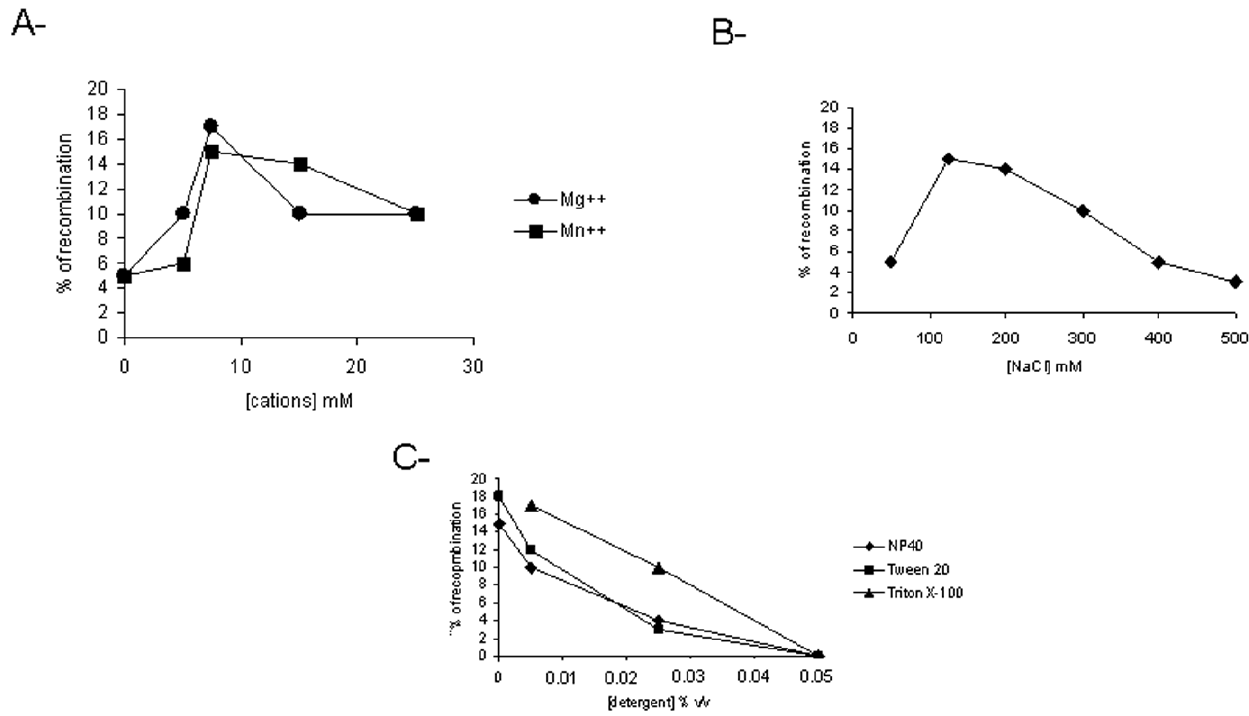
Figure 9. Effect of cations (A), salt (B) and detergent (C) on invitrorecombination catalyzed by IntI1. Recombination reactions were performed in the presence of 2 pmoles purified IntI1, 0.1 pmoles free attI1 * and 0.1 pmoles pGEM-T- attI1 and different concentrations of MgCl 2 , MnCl 2 NaCl and detergent as indicated. Recombination products were quantified with DNAJ software and are shown on the graphs as the percentage of recombinant product versus the total substrate.